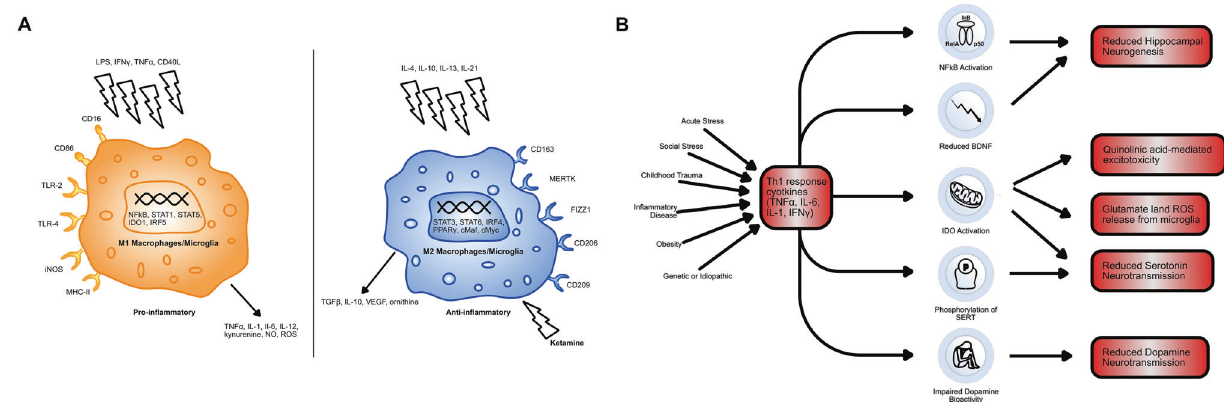
Fig. 1 Th1 dominance in depression and its amelioration by ketamine. A A diagram comparing M1 and M2 type macrophages. M1 macrophages are activated by pro-in fl ammatory signals, including LPS, Th1 cytokines (IFN γ , TNF α ) and Th1 cell surface proteins (CD40L). M2 macrophages are activated by Th2 cytokines (IL-4, IL-10, IL-13, IL-21) and by ketamine. M1 macrophages produce pro-in fl ammatory cytokines, as well as nitric oxide (NO) and neurotoxic kynurenine and reactive oxygen species and thus mediate the Th1 response. Ketamine causes the polarisation of monocytes to M2 macrophages. This acts to promote the release of anti-in fl ammatory TGF β , IL-10 and ornithine. It also reduces monocyte differentiation to M1 macrophages, hampering the effects of Th1 dominance. B A schematic showing the possible causes of Th1 dominance in patients with treatment-resistant depression and the downstream consequences of this excessive Th1 immune activation. Indoleamine 2,3-dioxygenase (IDO) activation is central to in fl ammation-induced depression via its effects on tryptophan metabolism and generation of neurotoxicity. IDO-mediated changes in tryptophan metabolism reduce serotonin, as does phosphorylation of serotonin transporters (SERT). Brain-derived neurotrophic factor (BDNF) exacerbates the negative effects of IDO activation on hippocampal volume by reducing hippocampal neurogenesis, as does nuclear factor kappa B (NFkB)